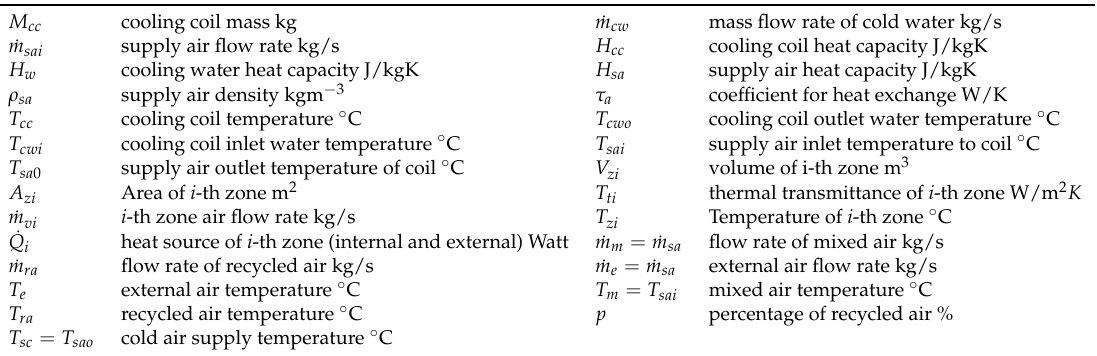
Table 2. Definitions of the parameters used in the modeling of the variable air volume air conditioning system.